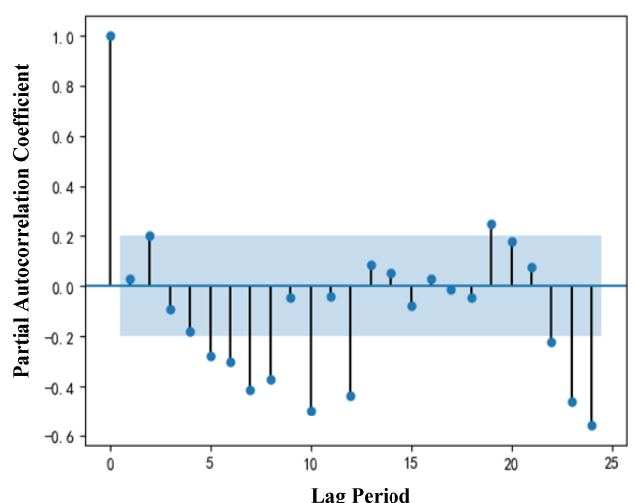
Figure 11. Offset distance ACF analysis.